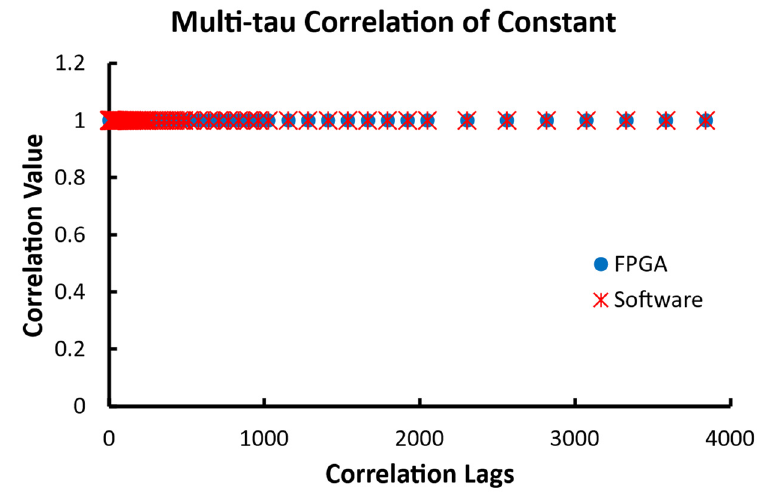
Figure 15. The outputs of 80 correlation lags from the multi-tau FPGA correlator and the multi-tau software correlator when the input data are constants of 1. The correlation lag doubles every 8 lags after the initial 16 lags.